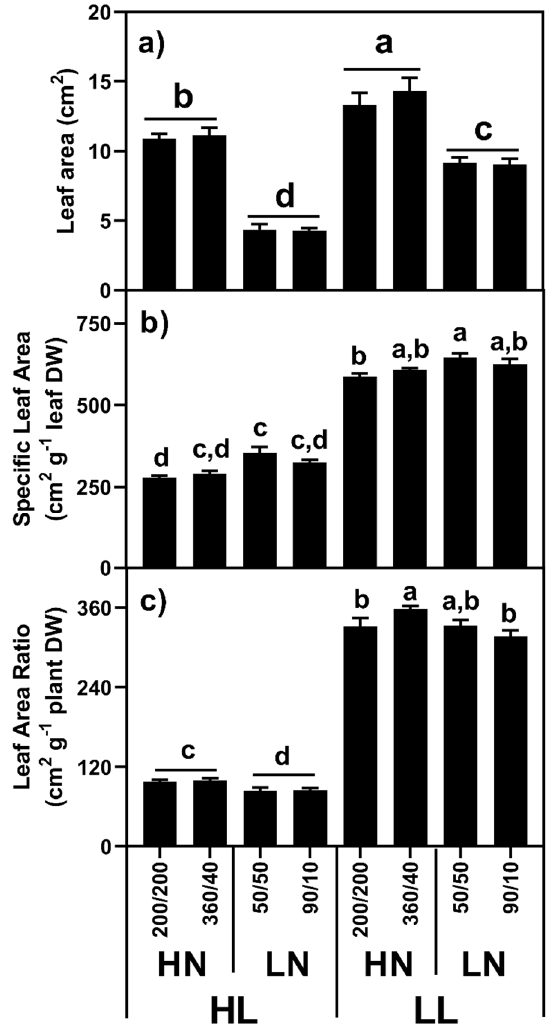
Figure 3. ( a ) Leaf area, ( b ) specific leaf area, and ( c ) plant SLA (leaf area/plant mass) for Poa annua plants grown under high (HL) or low light (LL) conditions and supplied high (HN: 400 µg) or low N (LN: 100 µg) equally (200/200 or 50/50) or unequally (360/40 or 90/10) between root box chambers, where n = 12. Different letters in the shoot graphs indicate statistically significant differences between light and nitrogen treatments.